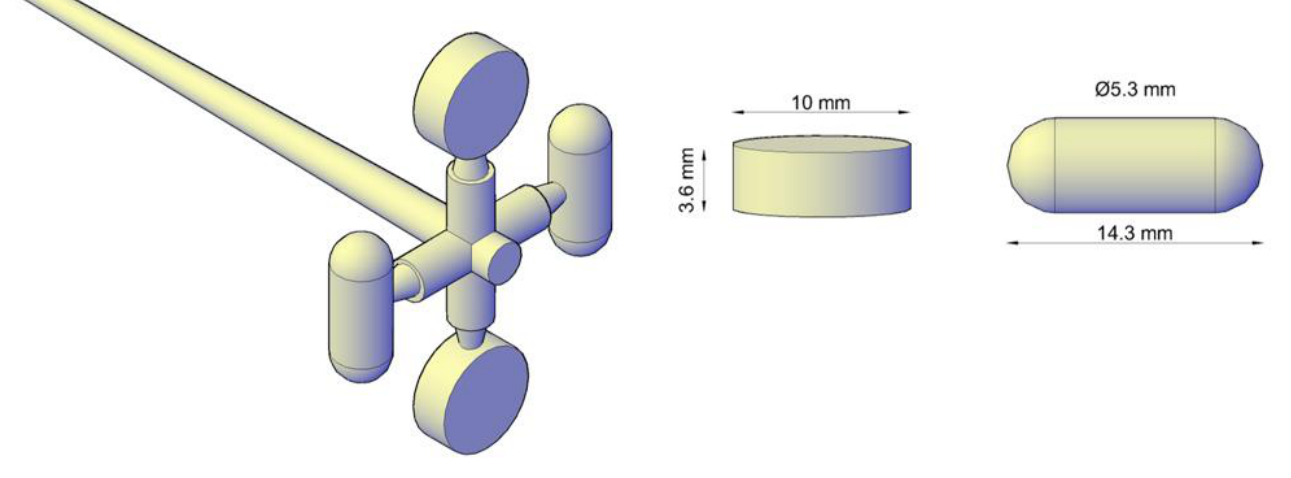
Figure 1. Dimensions of the µIM cavities in the shape of tablet and capsule modelled in Autodesk AutoCAD 2021.